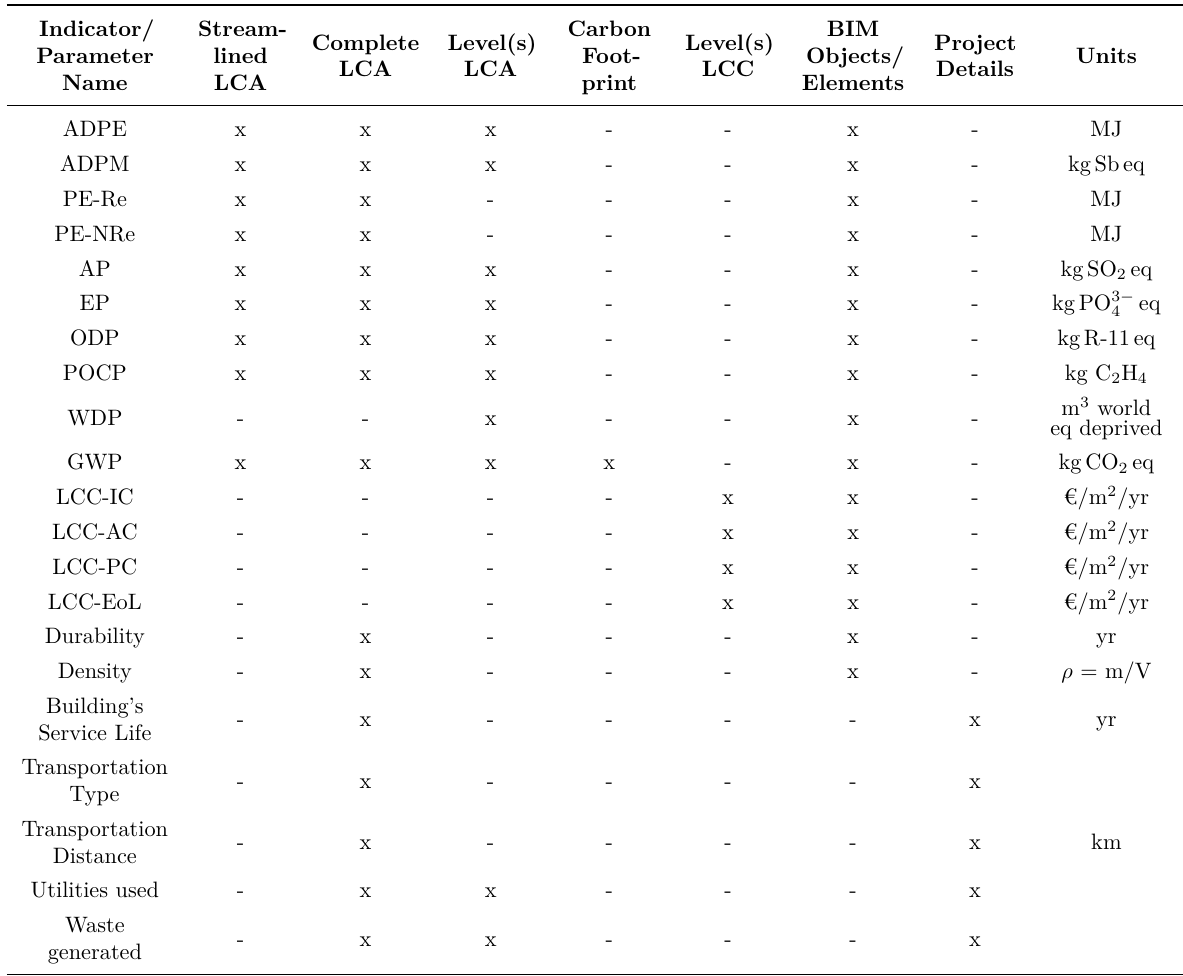
Table 1. Proposed PDT.